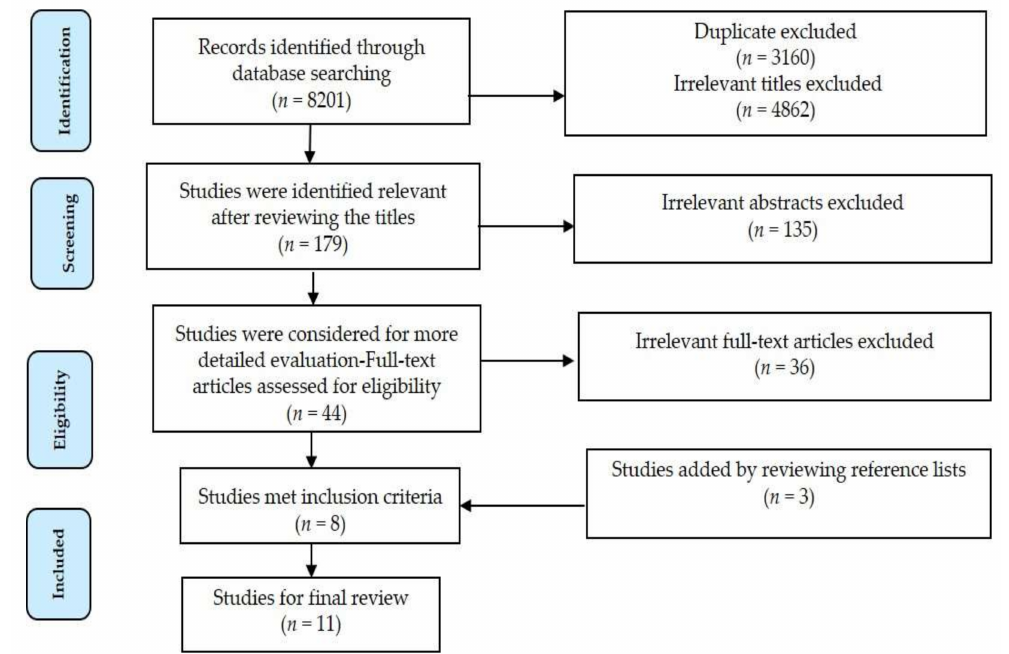
Figure 1. Literature search and study